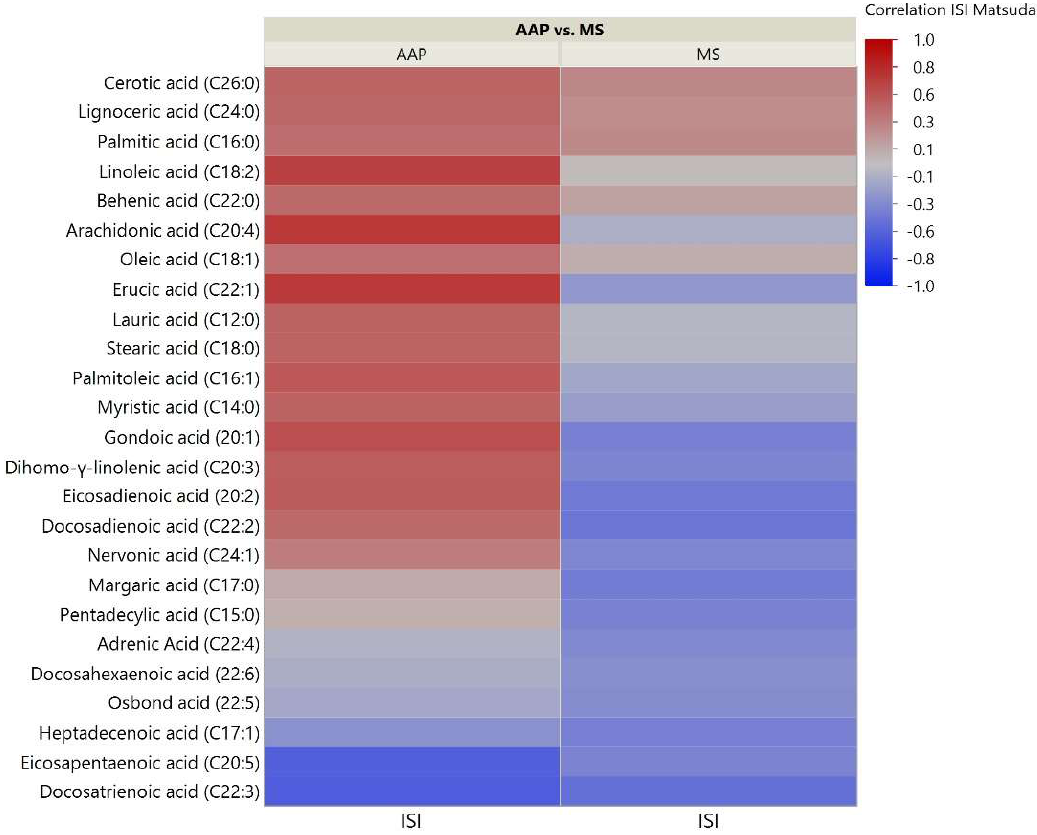
Figure 2. Correlation heatmap of insulin sensitivity and TFAs. The heatmap shows degree of correlation between individual TFA species and insulin sensitivity measured by the Matsuda Insulin Sensitivity Index (ISI). Lipids are ordered by the average ascending correlation value. AAP: atypical antipsychotic, and MS: mood stabilizer.